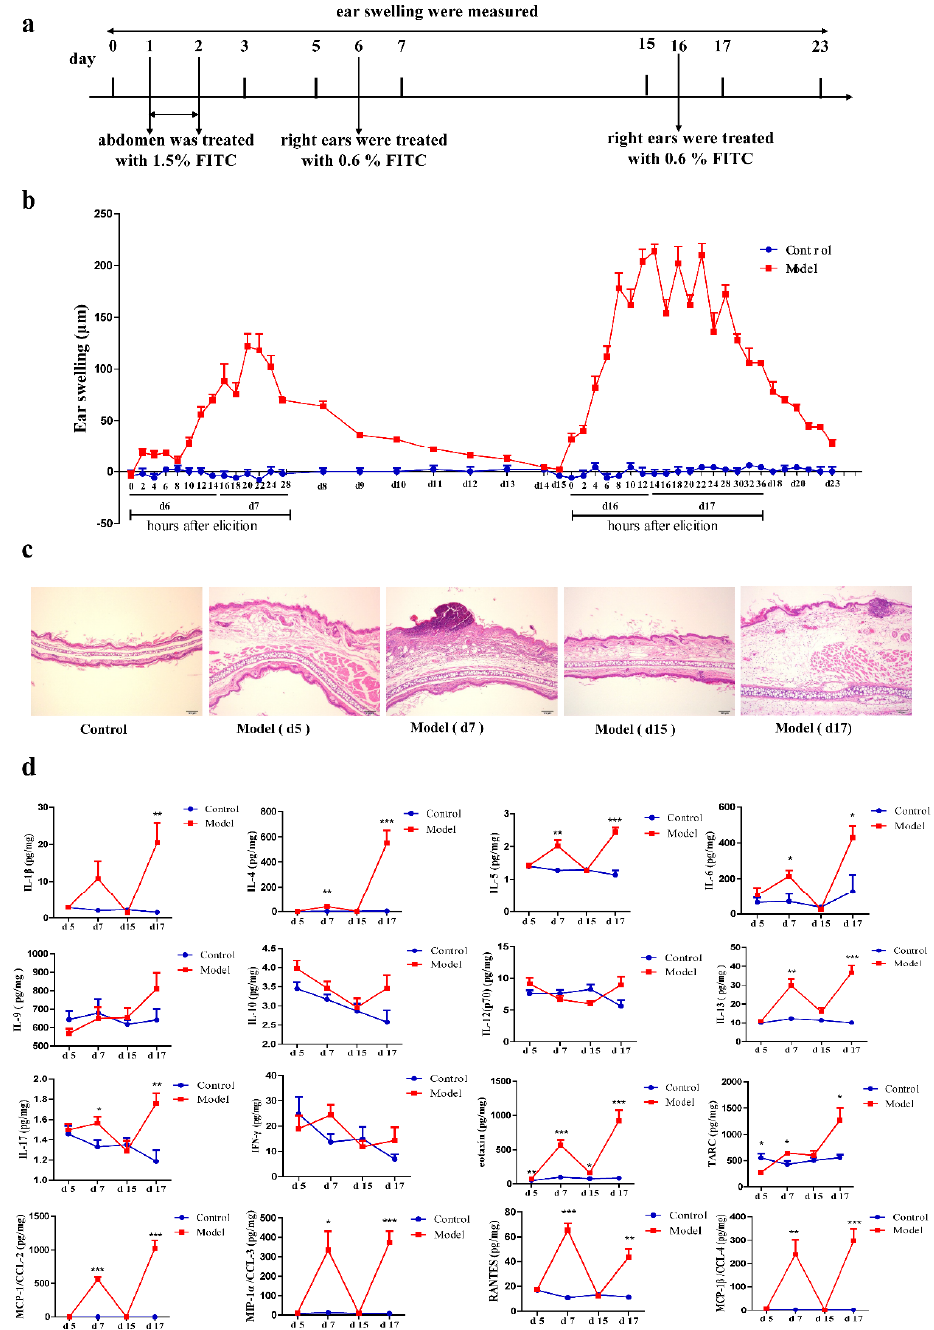
Figure 1. Mouse Th2-mediated atopic dermatitis (AD) recurrence model. ( a ) Flow charts of the FITC-induced AD recurrence model. ( b ) The change of ear thickness is systematically observed during the establishment of the AD recurrence model. The differences between the right and left ear weights were calculated ( n = 8). ( c ) Histopathological findings with hematoxylin & eosin staining of ear skin sections at different phases of the AD recurrence model ( n = 5, magnification: 200×). ( d ) The expression of the cytokines IL-1 β , IL-4, IL-5, IL-9 IL-10, IL-12(p70), IL-13, IL-17, IFN- γ , TSLP, IL-33, eotaxin, and TARC, as well as the chemokines MCP-1/CCL-2, MIP-1 α /CCL-3, MCP-1 β /CCL-4, and RANTES, in the ear tissue homogenate of different phases of the AD recurrence model (mean ± SD, n = 8, compared with control: * p < 0.05, ** p < 0.01, *** p <